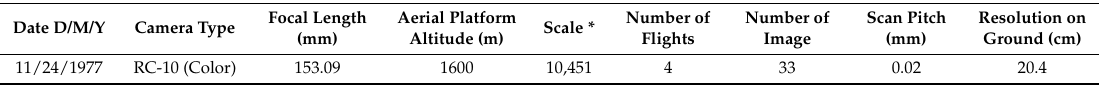
Table 1. Aerial photograph properties used in this study.